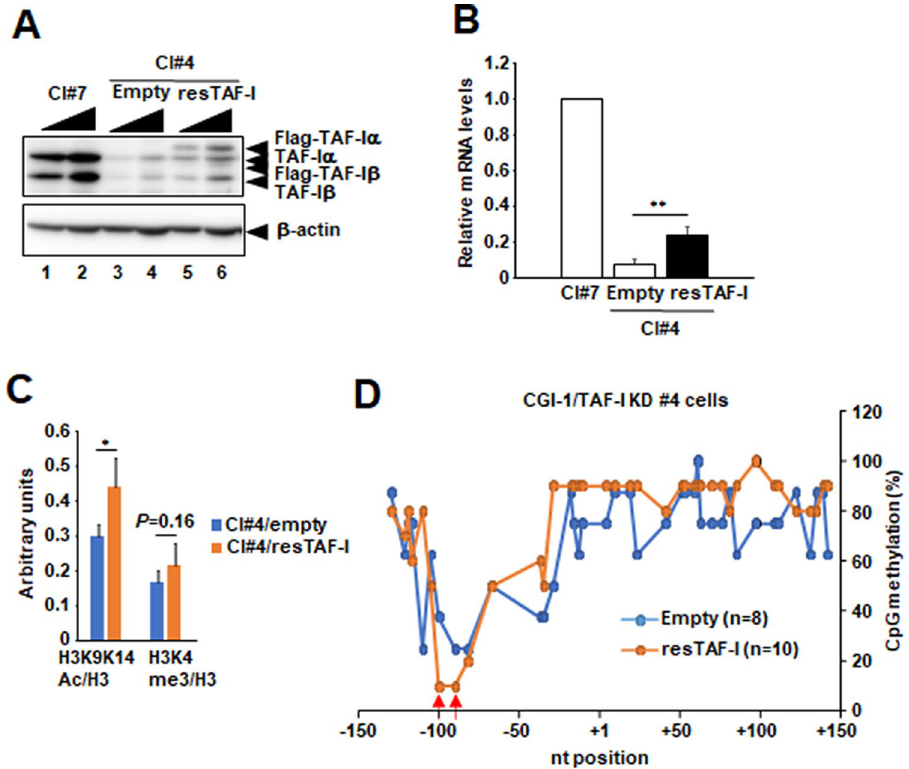
Figure 7. Transient expression of TAF-I partially rescued TERT transcription in TAF-I KD cells. ( A ) TAF-Iα and TAF-Iβ expression levels were examined by western blotting analyses in TAF-I KD clone #4 cells transfected with plasmid DNAs expressing shRNA-resistant Flag-TAF-Iα and Flag-TAF-Iβ (resTAF-I). Total cell extracts prepared from WT clone #7 cells (lanes 1–2), and TAF-I KD clone #4 cells transfected with empty vector DNA (lanes 3–4) or vector DNAs expressing resTAF-I (lane 5–6) were separated on 10% SDS-PAGE followed by western blotting analyses using anti-TAF-Iα/β and anti-β-actin antibodies. Ten (lanes 1, 3, and 5), and twenty (lanes 2, 4, and 6) µg of total protein prepared from each cell line was loaded. ( B ) The expression level of TERT mRNA was examined. Total RNA was isolated from each cell, and were subjected to Q-RT-PCR analyses to examine the expression level of TERT mRNA. The 18S rRNA was used for normalization as an internal control. Values represent the mean ± SD (n = 3). ** P < 0.01 relative to #4 transfected with empty vector DNA. ( C ) The level of histone H3, H3K9K14ac, and H3K4me3 around the TERT TSS including core promoter was examined by ChIP assay. The value of each histone H3 modification was normalized by that of histone H3. Arbitrarily units were represented at vertical line. Values represent the mean ± SD (n = 3). * P < 0.01. ( D ) Bisulfite sequencing analyses. The methylation level of each CpG dinucleotide in CGI-1 of the TERT locus was compared between TAF-I KD clone #4 cells transfected with empty vector DNA and vector DNAs expressing resTAF-I. The horizontal line indicates nucleotide positions from the TERT TSS, and the vertical line indicates the percentage of CpG methylation. Two CpG nucleotides we observed reduction of methylation level by expression of resTAF-I were indicated by red